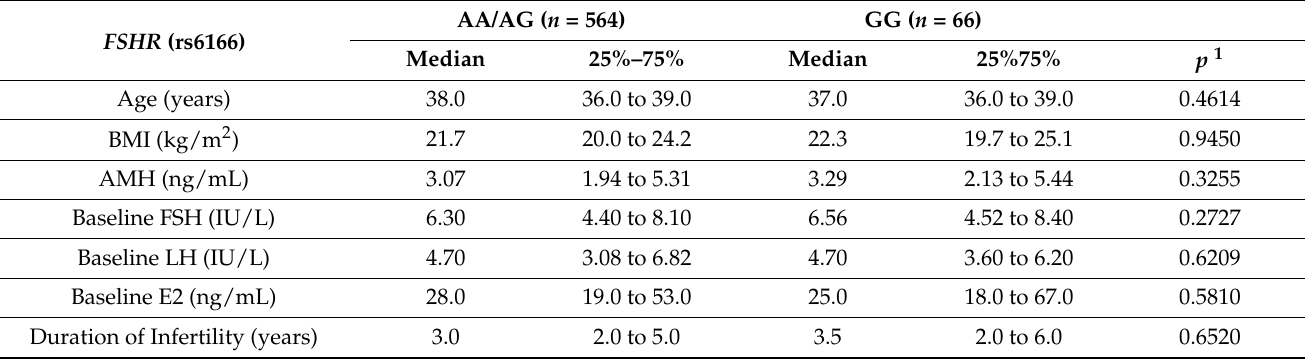
Table 5. Clinical characteristics for older patients ( ≥ 35 years) with AMH ≥ 1.2 ng/mL ( n = 630) undergoing ART treatment according to genotype of FSHR SNP